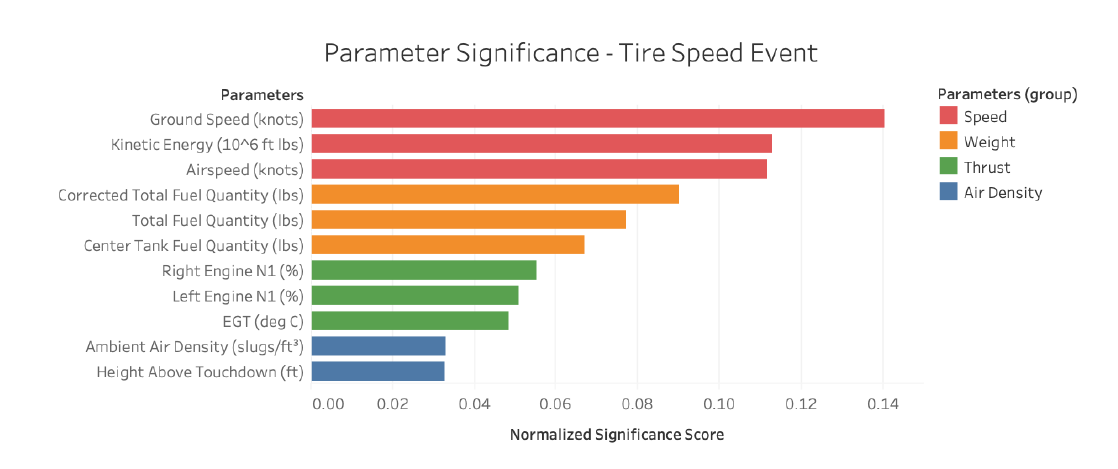
Figure 7. Normalized critical parameter significance for the Tire Speed Event obtained from application of SAFE framework.